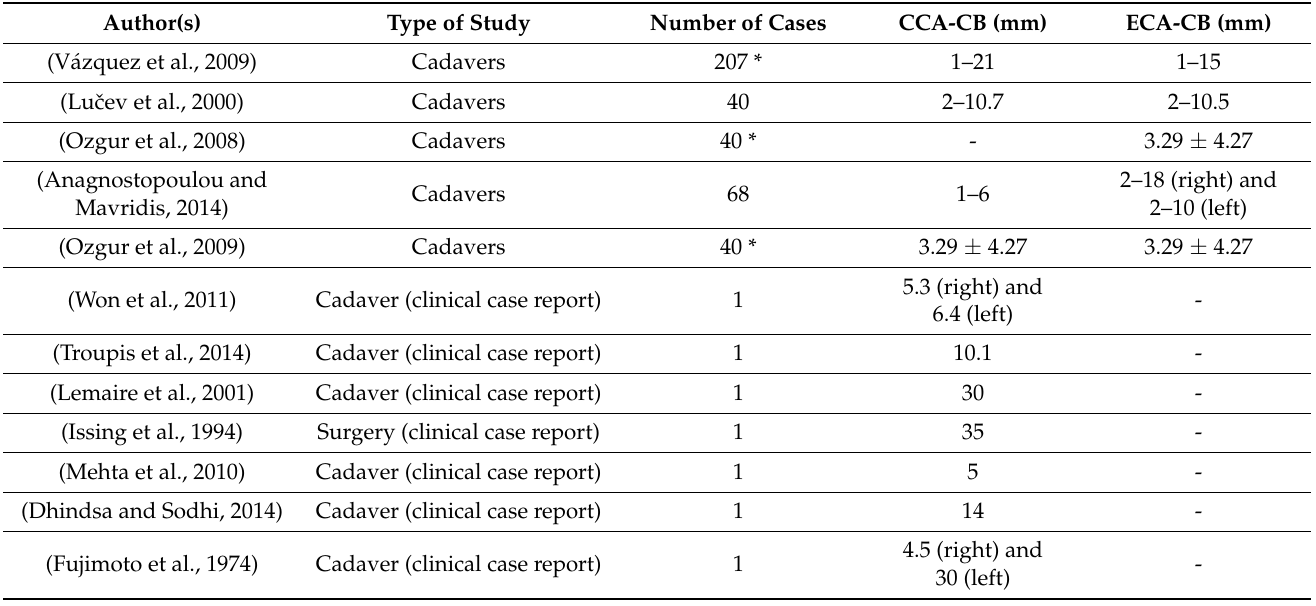
Table 2. Available data concerning STA origin and distance from